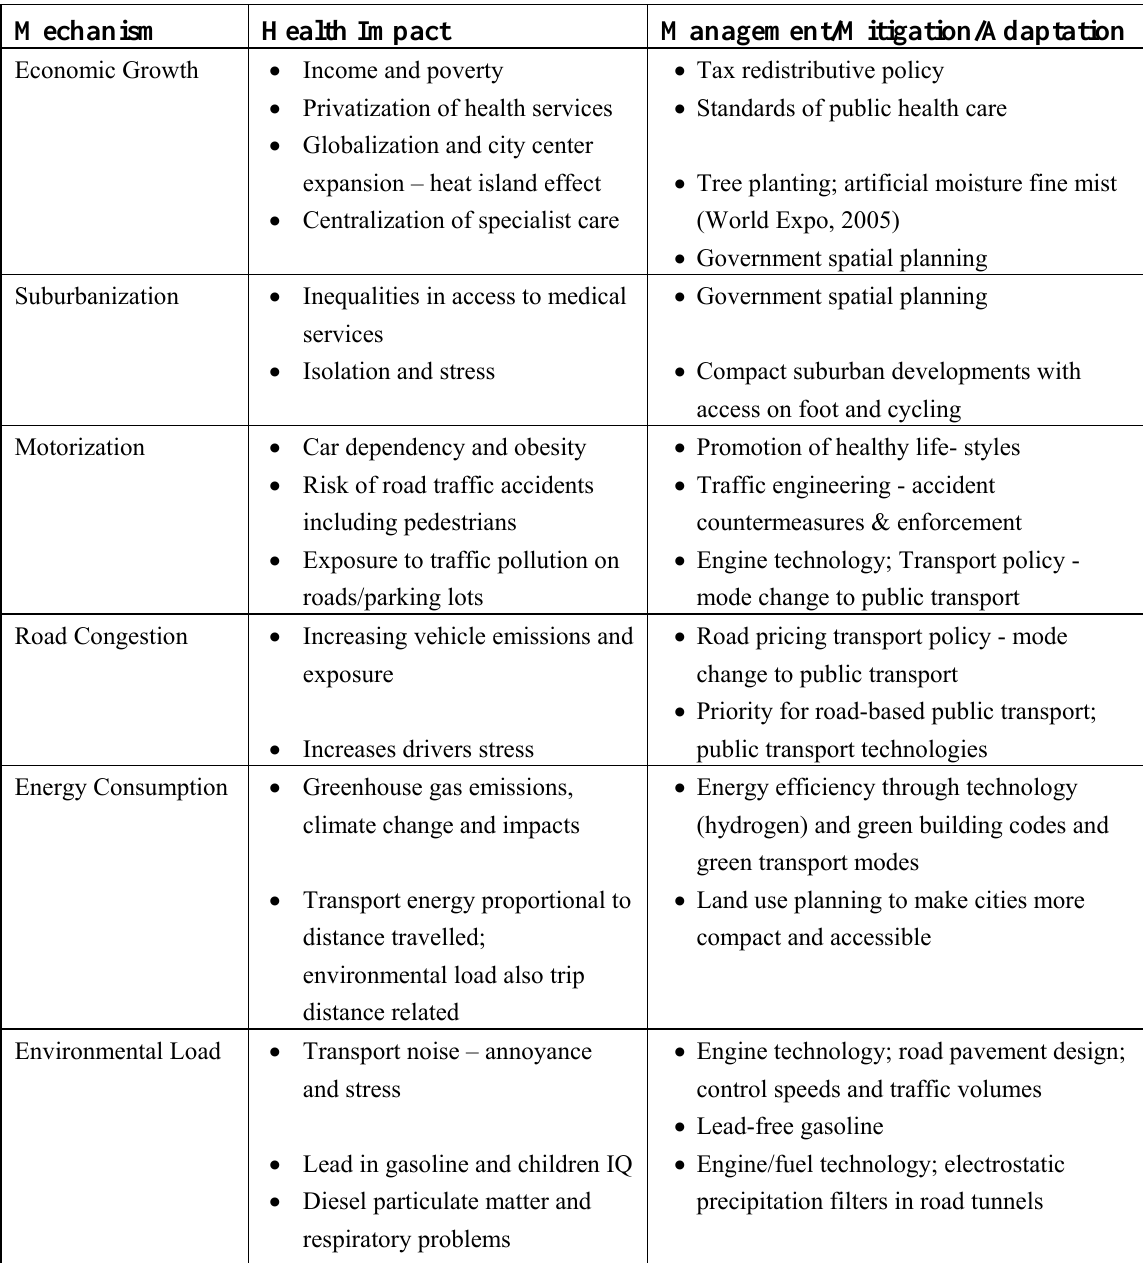
Table 2. Mechanisms of Urban Development, Health Impacts and Potential